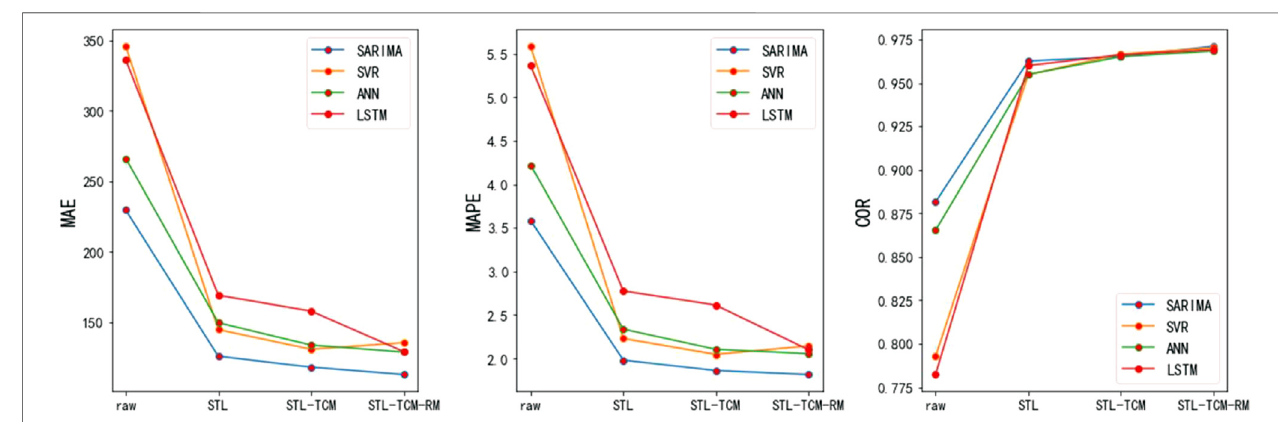
FIGURE 6 | Comparison between different models for 1-month ahead forecasting.